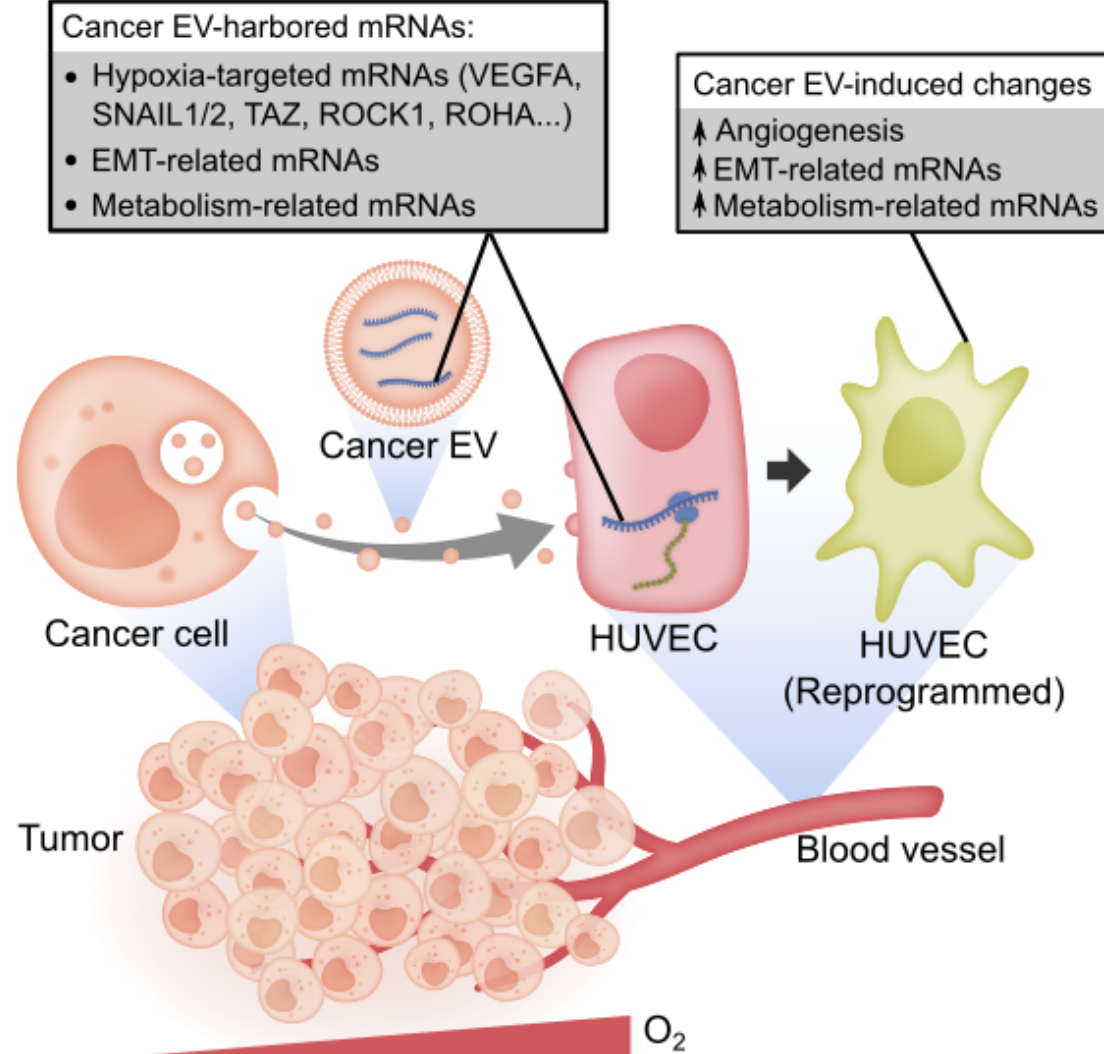
Figure 7. Summary model. Cancer cell-derived EVs carry diverse mRNAs including hypoxia-targeted mRNAs, EMT-related mRNAs and metabolism-related mRNAs. The EV-mRNA profile is not strongly correlated with cell mRNA profile. A proportion of these EV-mRNAs can be regulated by the hypoxic stress in the tumor microenvironment. Cancer EVs deliver translatable mRNAs, such as VEGFA, to HUVECs, which contribute to activating the HUVECs toward an angiogenic phenotype, accompanied by the upregulation of EMT-related and metabolism-related genes in HUVECs.